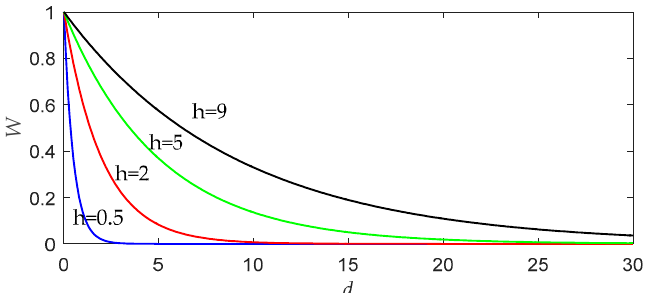
Figure 1. Variations of weight with distance under different bandwidth values.